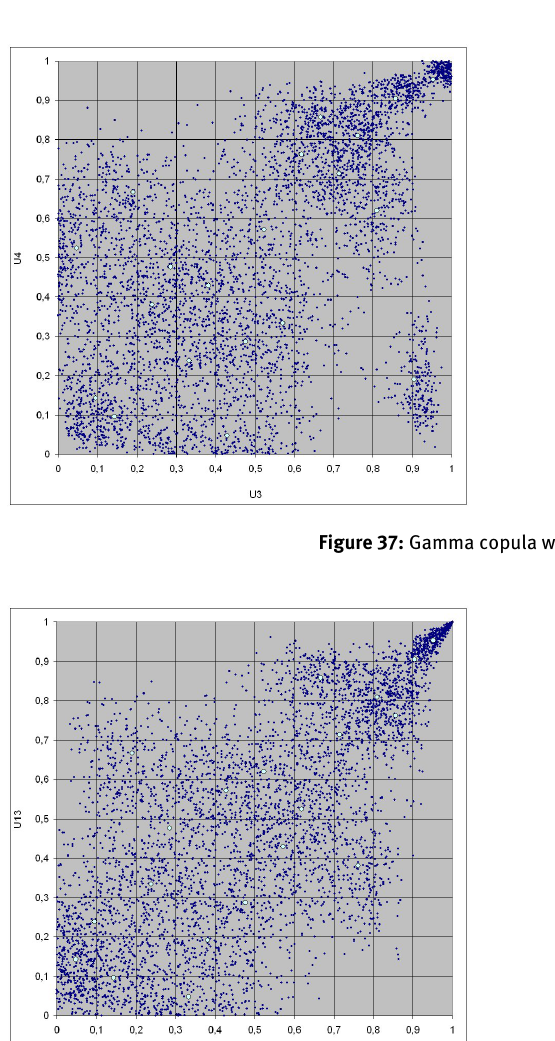
Figure 36: Gamma copula with the rook copula driver, I